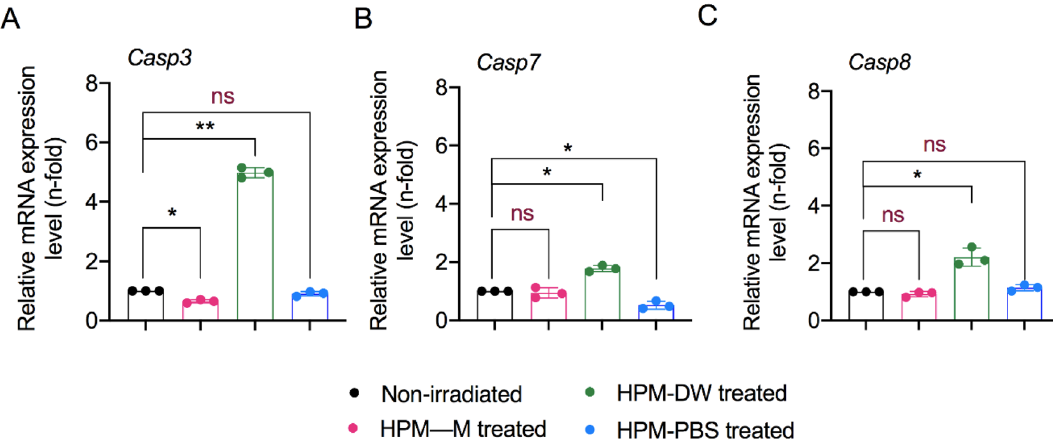
Figure 8. Effect of high power microwave-irradiated solutions on expression of cell death markers. Relative mRNA expression for apoptotic genes ( A ) Casp3, ( B ) Casp7, and ( C ) Casp8 in U373MG cells. The treatment groups are color-coded as shown in the figure. * p < 0.05, ** p < 0.01, *** p <